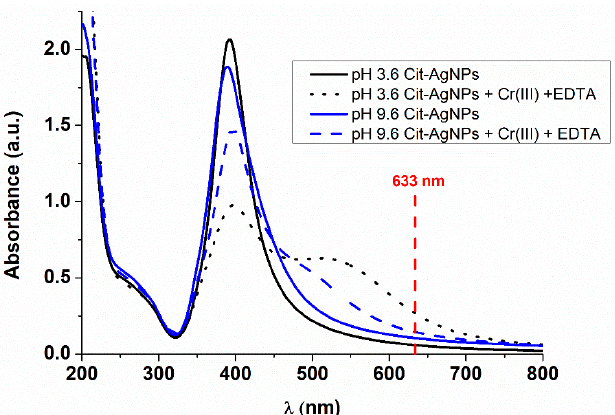
Figure 1. UV-visible spectra of citrate capped silver nanoparticles. Black solid line: Cit-AgNPs at pH = 3.6; black dot line: Cit-AgNPs in presence of the mixture Cr (III) + EDTA at pH = 3.6; blue solid line: Cit-AgNPs at pH = 9.6; blue dashed line: Cit-AgNPs in presence of the mixture Cr (III) + EDTA at pH = 9.6.